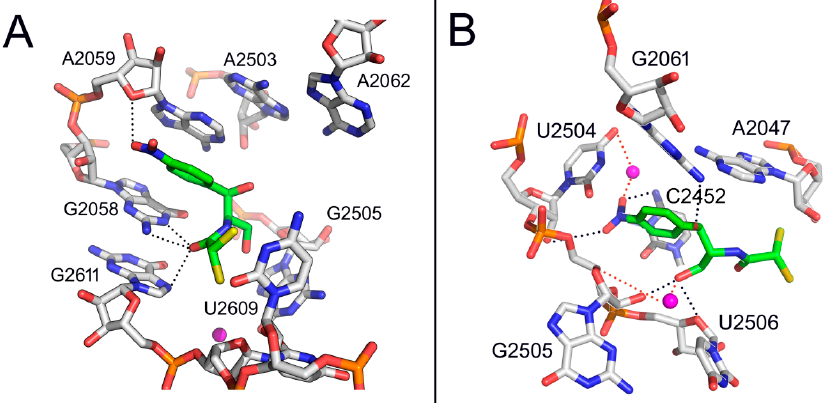
Figure 2. Binding positions of CAM (in green) in the ( A ) Haloarcula marismortui and ( B ) Deinococcus radiodurans ribosome, as detected by crystallography (PDB ID code 1NJI and 1K01, respectively).